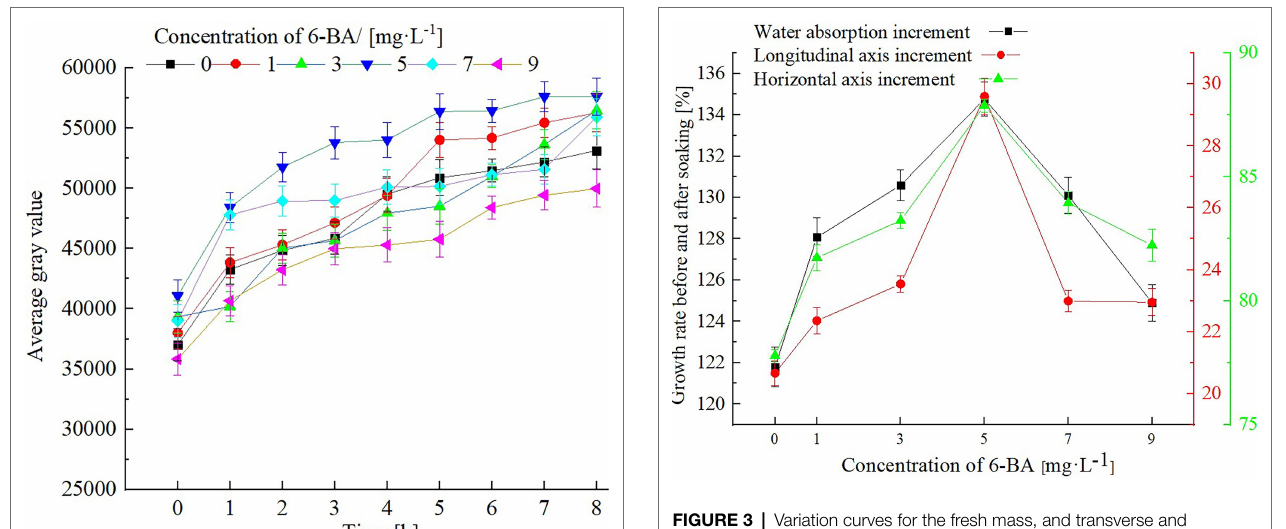
FIGURE 3 | Variation curves for the fresh mass, and transverse and longitudinal axis diameter growth rates before and after immersion in various 6-BA